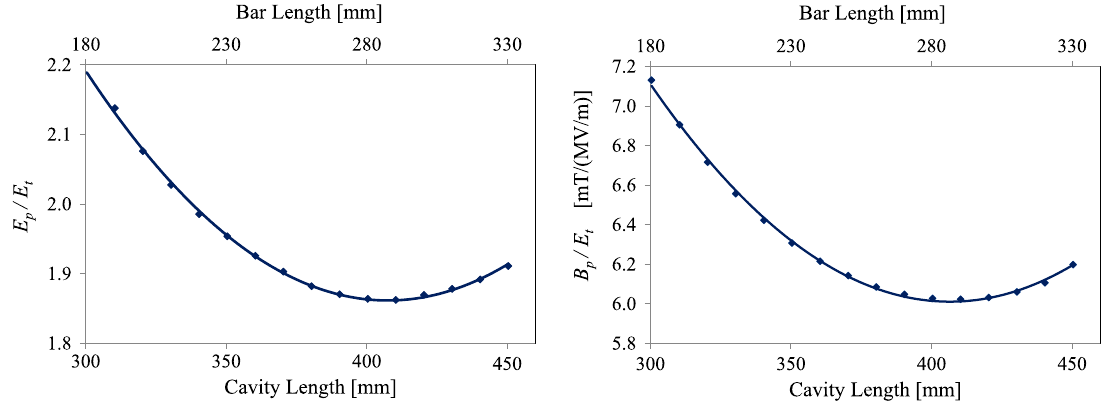
FIG. 16. Ratios of peak surface electric field ( E p ) and magnetic field ( B p ) to the transverse electric field ( E t ) with varying cavity length for race-track-shaped parallel bars [Design